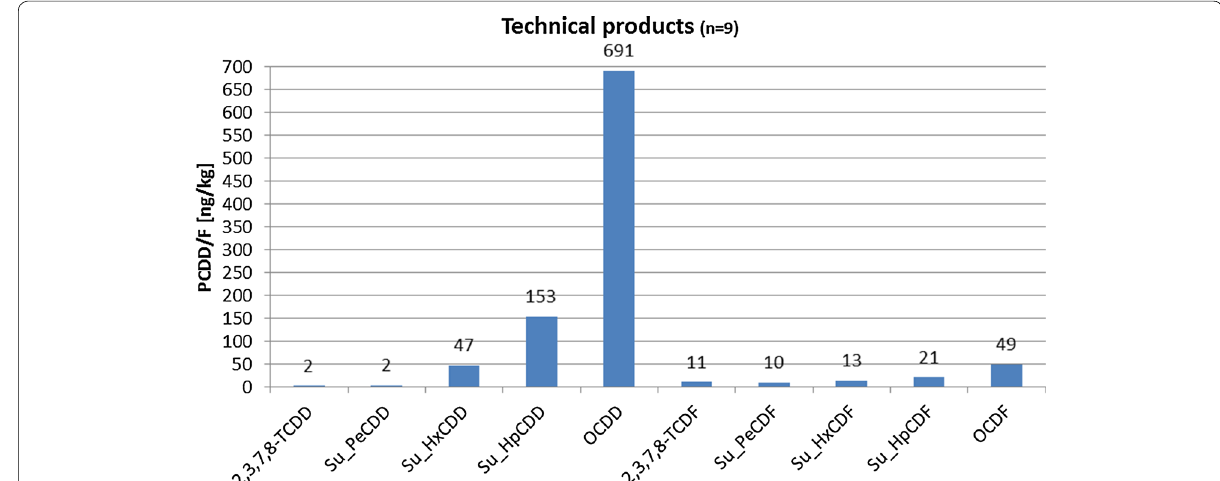
Fig. 9 Homologue pattern of technical products (UBA) (Data taken from